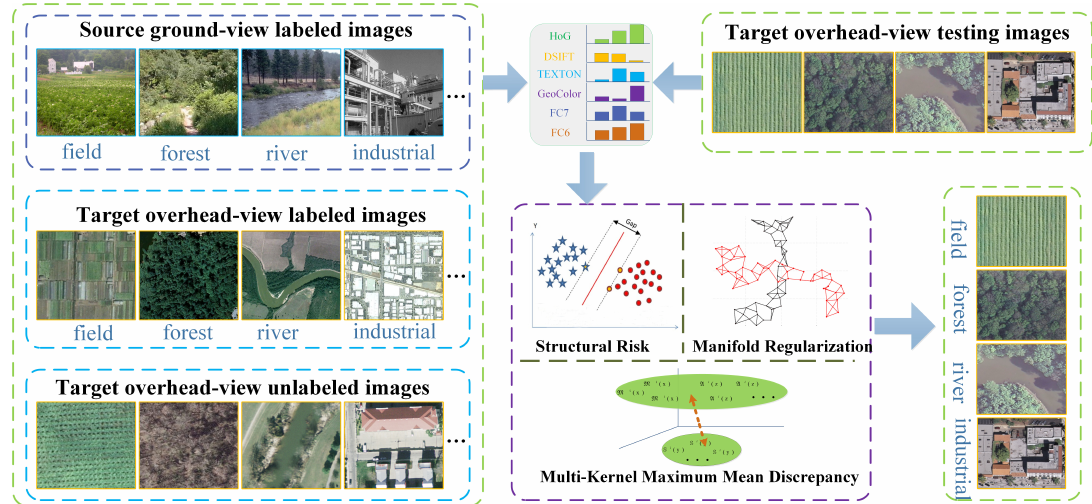
Figure 2. The flowchart of semi-supervised manifold-regularized multiple kernel